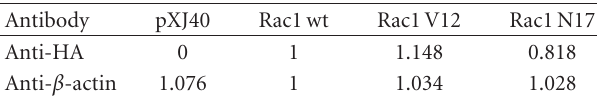
Figure 4: Graphical representation of cell motility: lane 1, motility of cells expressing wild-type Rac1 alone (indicated as Rac1 wt); lane 2, cells expressing constitutively activated Rac1 G12V (indicated as Rac1 V12); lane 3, cells expressing dominant negative Rac1 T17N (indicated as Rac1 N17); lane 4, cells coexpressing Wild-type Rac1 and Wild-type replicative HBV genome (indicated as Rac1 wt & HBV wt); lane 5, cells expressing Wild-type Rac1 and P-A mutant replicative HBV genome (indicated as Rac1 wt & HBV mutant); lane 6, cells expressing wile type replicative HBV genome (indicated as HBV wt); lane 7, cells expressing P-A mutant replicative HBV genome (indicated as HBV mutant). Table 1: Normalized densities of the bands in Figure 2(a). The densities of Rac1 wt were taken as 1